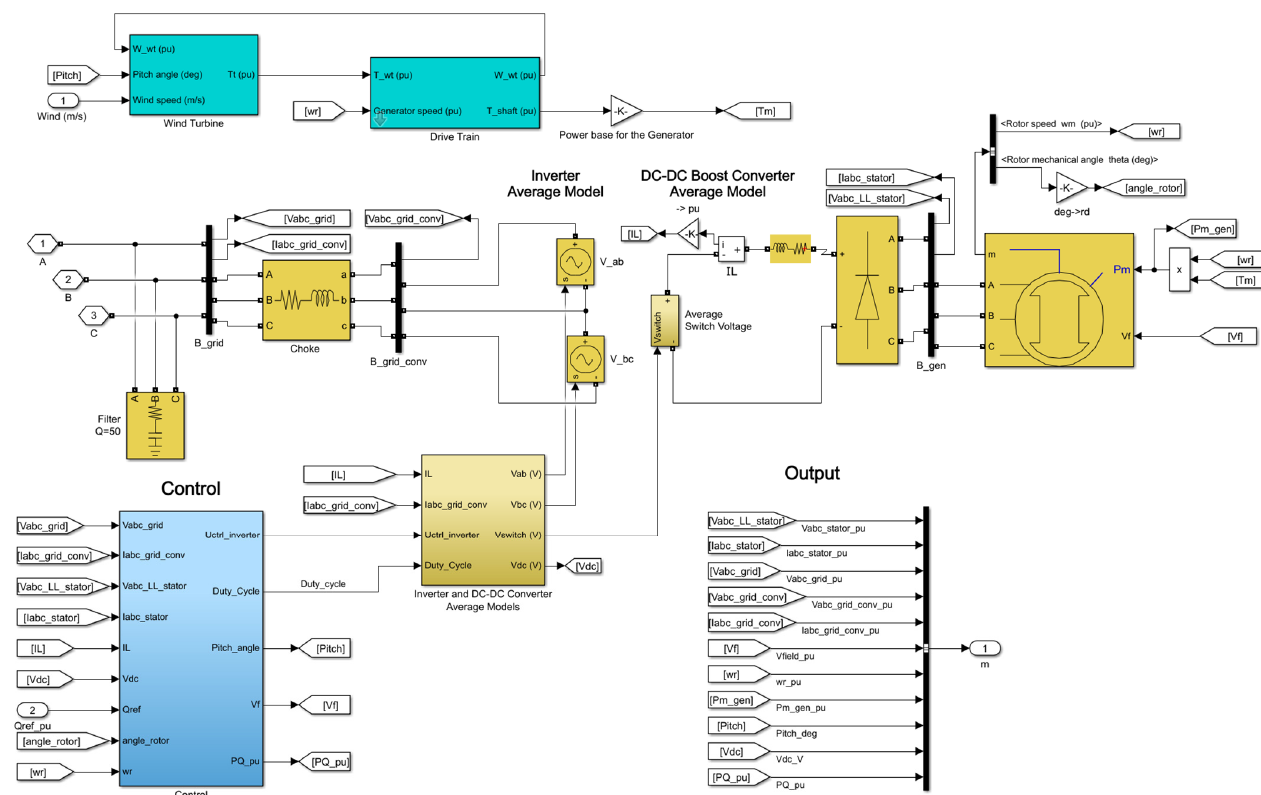
Figure 12. Simulink model of the wind generator and the control system.